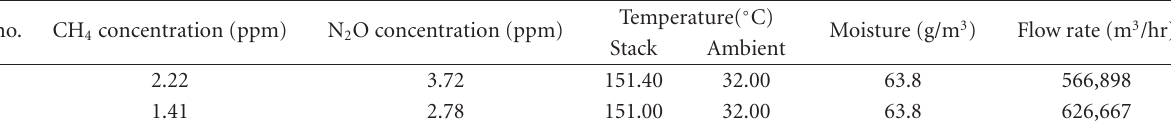
Table 7: Non-CO 2 concentration and exit condition of exhaust gas from stacks in the anthracite Fluidized Bed power plants. Stack no.